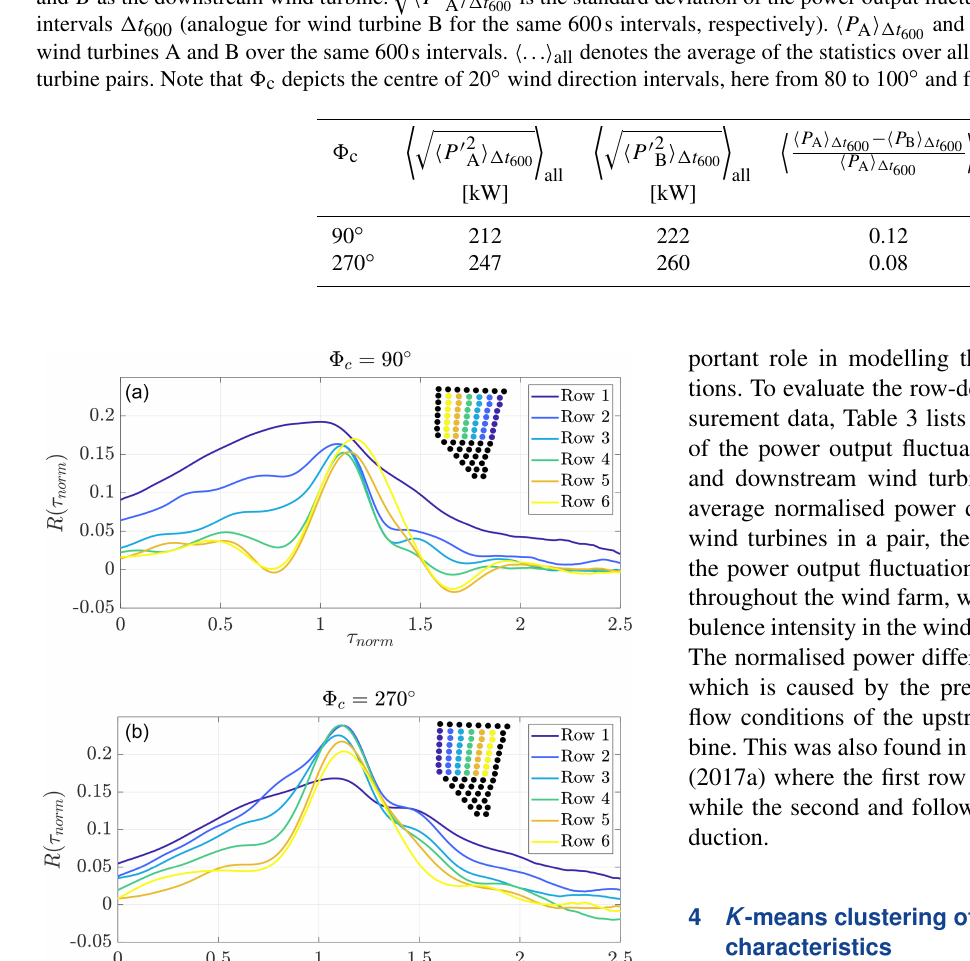
bines. Here, a clear correlation is found. For the correlation curves of the second to last row, the peaks become more de- fined as their width